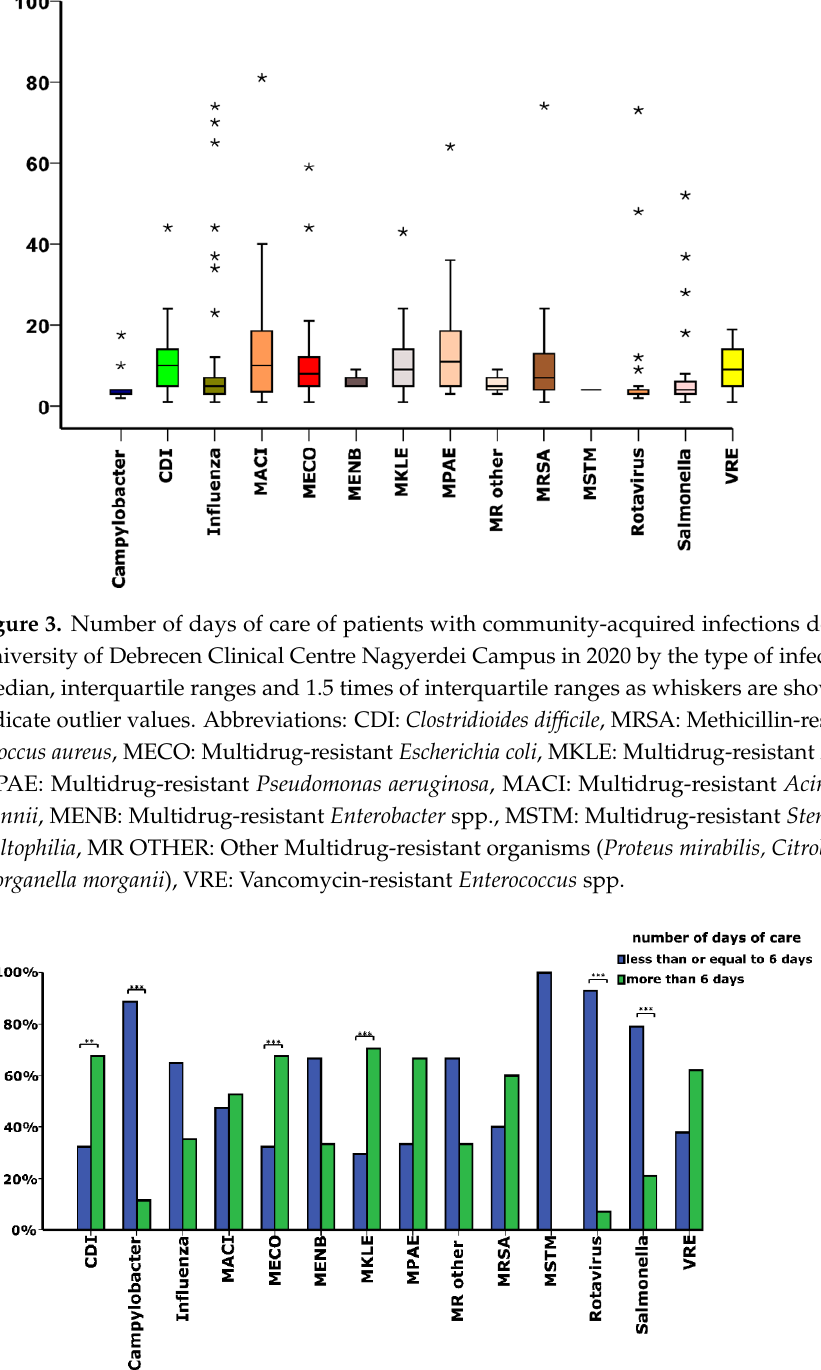
Figure 4. Distribution of patients with community-acquired infections detected at the University of Debrecen Clinical Centre Nagyerdei Campus by the median number of days of care in 2020. Patients with community-acquired infections were divided into two groups based on the median number of days of care ( ≤ 6 days versus >6 days of hospitalisation). Abbreviations: CDI: Clostridioides difficile , MRSA: Methicillin-resistant Staphylococcus aureus , MECO: Multidrug-resistant Escherichia coli , MKLE: Multidrug-resistant Klebsiella spp . , MPAE: Multidrug-resistant Pseudomonas aeruginosa , MACI: Multidrug-resistant Acinetobacter baumannii , MENB: Multidrug-resistant Enterobacter spp . , MSTM: Multidrug-resistant Stenotrophomonas maltophilia , MR OTHER: Other Multidrug-resistant organisms ( Proteus mirabilis, Citrobacter freundii, Morganella morganii ), VRE: Vancomycin-resistant Enterococcus spp . ** p < 0.01, *** p < 0.001